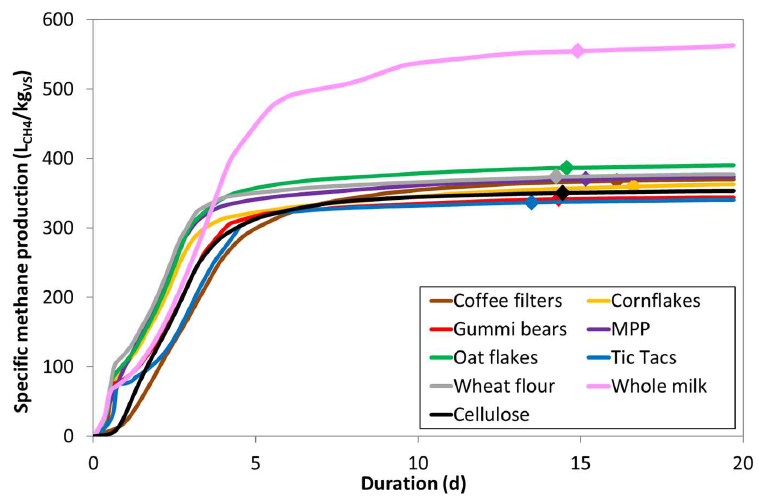
Figure 1. Average specific methane production of microcrystalline cellulose ( n = 9) and the eight alternative positive control substrates ( n = 3) tested. Diamonds indicate the time when the daily gas production was below 1% of cumulative production during three consecutive days. Table 2. Summary of time to reach BMP 1% net, 3d as well as a comparison of theoretical maximum and